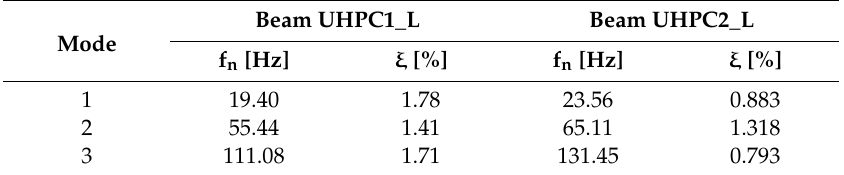
Figure 10. Sketch of cracks in ( a ) UHPC1_L after the test procedure and ( b ) UHPC2_L after the test procedure. Table 9. Modal parameters for the first three modes (LSCE method) in the damaged state of the